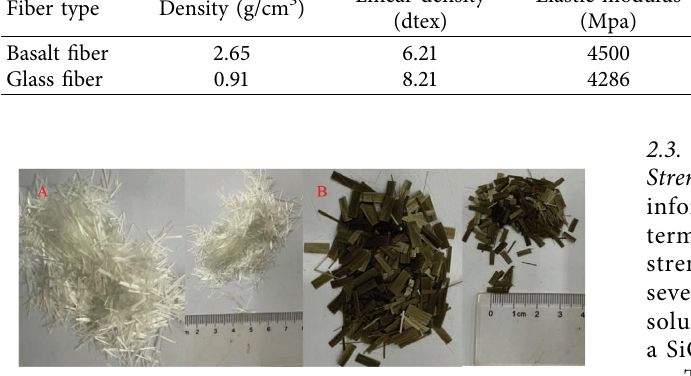
Figure 2: Material diagram: (a) glass fber and (b) basalt